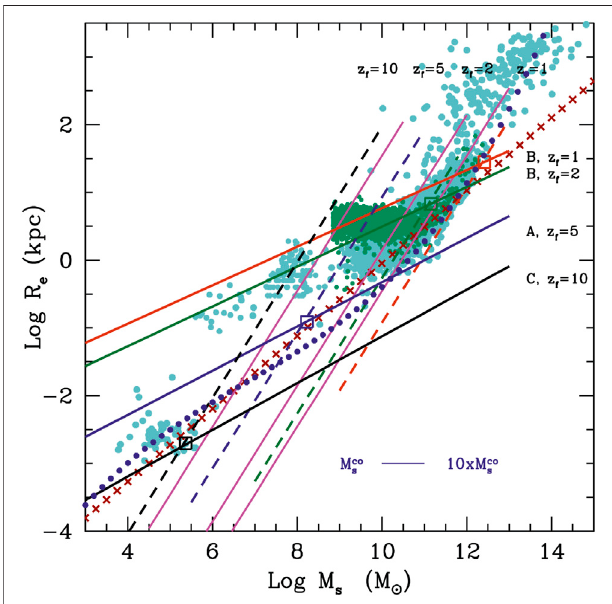
FIGURE 4 | The Mass-Radius plane. Comparison between data and theory. Radii R e and stellar masses M s are in kpc and M 0 , respectively. The pale-blue fi lled circles are the observational data, the sea-green fi lled circles the models of Illustris. The stellar masses of the observational data that refer to objects from GCs to CoGs span the range 10 4 – 10 14 M 0 while the theoretical data that are designed to represent galaxies span the mass range 10 8 – 10 12 M 0 . The theoretical data overlap the observational ones for ETGs and partly also for DGs. The linear best fi t of normal ETGs ( M T ≥ 10 10 M 0 ) givenby Eq.4 isthedark-redthickcrossedlinethatweprolongeddowntothe regionofGCsandupwardtothatofCoGs.ThefoursolidlineslabeledA( z f (cid:1) 5, blue), B ( z f (cid:1) 1, red and z f (cid:1) 2, dark green), and C ( z f (cid:1) 10 black) are the analytical relationships of Eq. 19 . They show the loci of galaxy models with different masses but constant initial density for different values of redshift of galaxy formation z f . These lines are the best fi t of the models by Chiosi and Carraro(2002),Merlinet al.(2012),and Chiosiet al.(2012).Themagentasolid linesvisualizethelocusofvirializedobjectsontheMR-planefordifferentvalues of the stellar velocity dispersion (50, 250, 500 km/s from left to right). The dashed blacklinesfordifferentvaluesof z f aretheMRRsexpectedforgalaxies with total mass equal to 50 × M CO ( z ), the cut-off mass of the Press-Schechter at varying z f according to relation (20). The large empty squares mark the intersections between the lines of constant initial density and the MRRs for 50 × M CO galaxies for equal values of the redshift. All the intersections lie very close to the relation of Eq. 4 shown by the dark-red crossed line. This is the linear interpretation of the observed MRR. Finally, the curved blue dotted line shows the expected MR relation for the baryonic component of DM halos whose mass distribution follows the cosmological HGF by Luki ć et al. (2007). The curve has been extended to include the GCs and the CoGs. Note the changing slope of the MRR passing from CoGs to ETGS and GCs. Remarkably, the curved line fi rst runs very close to the large empty squares, second to linear fi t of the data (crossed line), and third accounts for the observed MRR passing from GCs to CoGs (about ten orders of magnitude difference in the stellar mass). Finally, the horizontal blue line gives the interval for M s corresponding to initial masses M CO ( z ) < M T < 10 × M CO ( z ) (the percentage amounts to ≃ 15 % ). It highlights that at each redshift the high- mass edge of the MRR has a natural